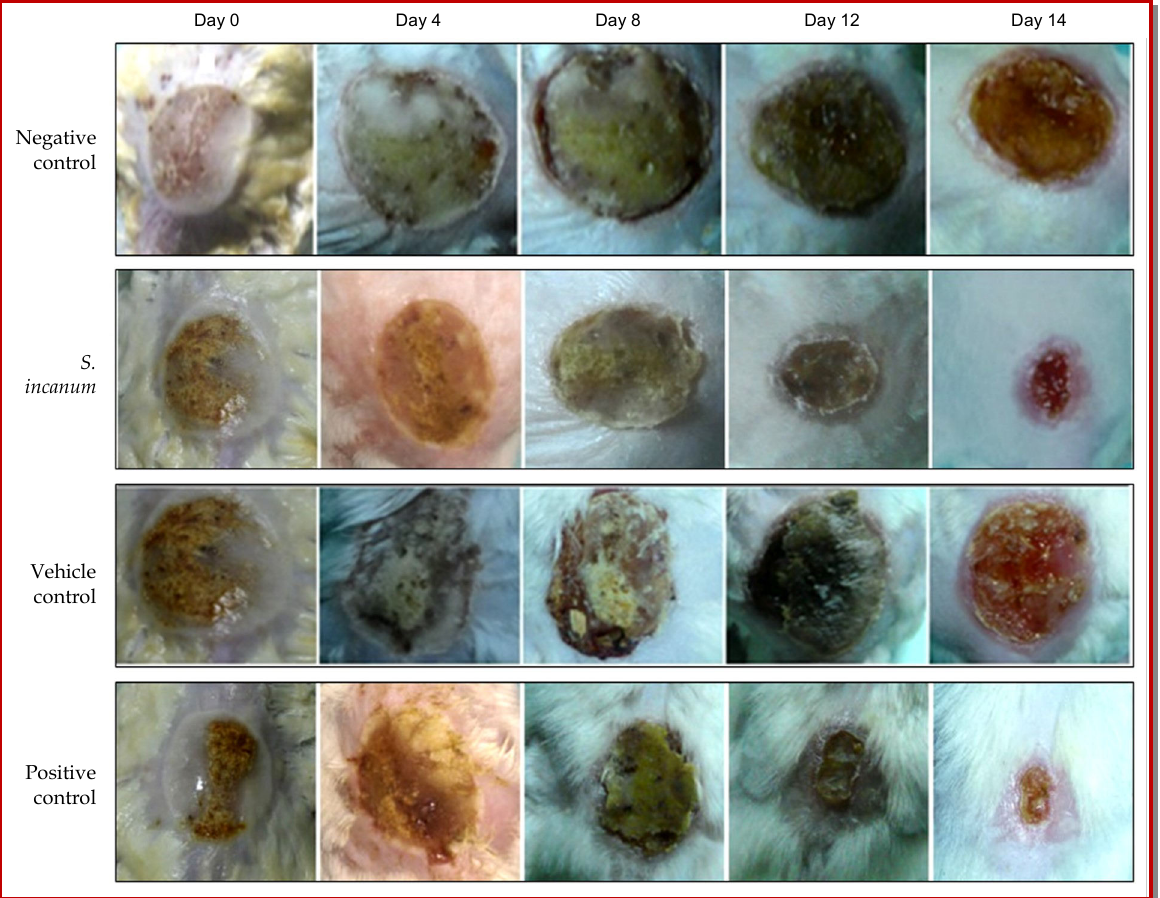
Figure 1: Photographic analysis of wound healing on different days of treatment in negative control, S. incanum , vehicle and posi- tive control